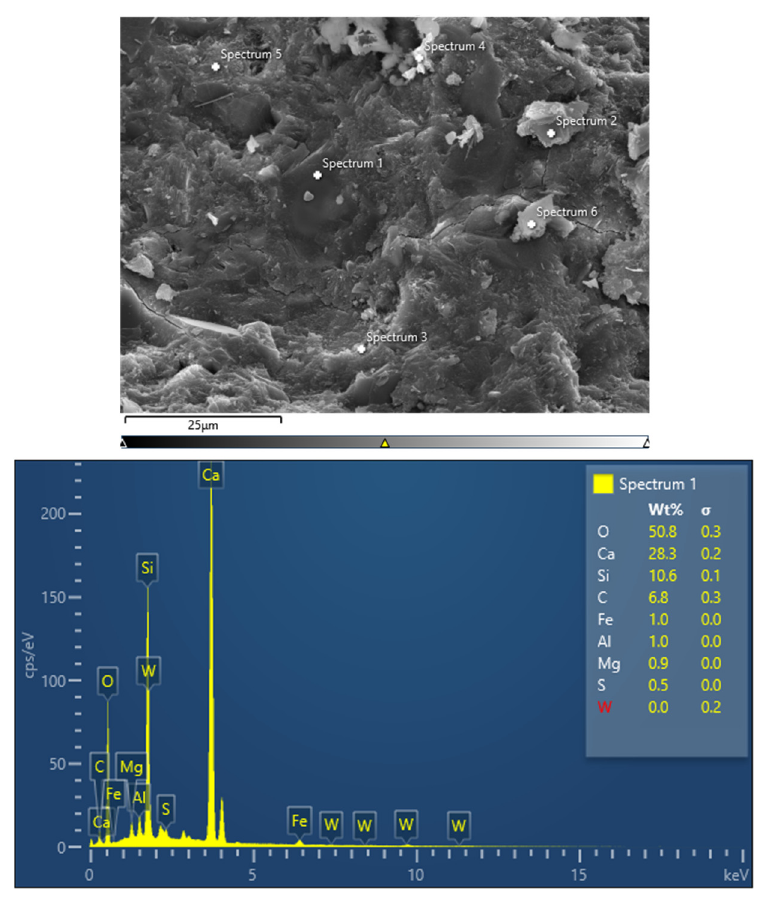
Figure 10. SEM-EDS diagram of tunnel slag concrete specimens. Table 12. Results of EDS analysis of tunnel cavity slag concrete.